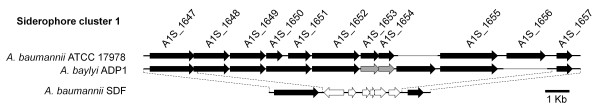
Comparison of siderophore cluster 1 in sequenced Acinetobacter isolates. The alignment of siderophore cluster 1 between strain ATCC 17978, ADP1 and SDF. Arrows indicate open reading frames, in black genes with high homology (> 50% identity) and in grey genes with low homology (< 50% identity). White genes represent a 3.5 Kb transposon insertion, which replaced the A1S_1648-1656 orthologs in strain SDF.